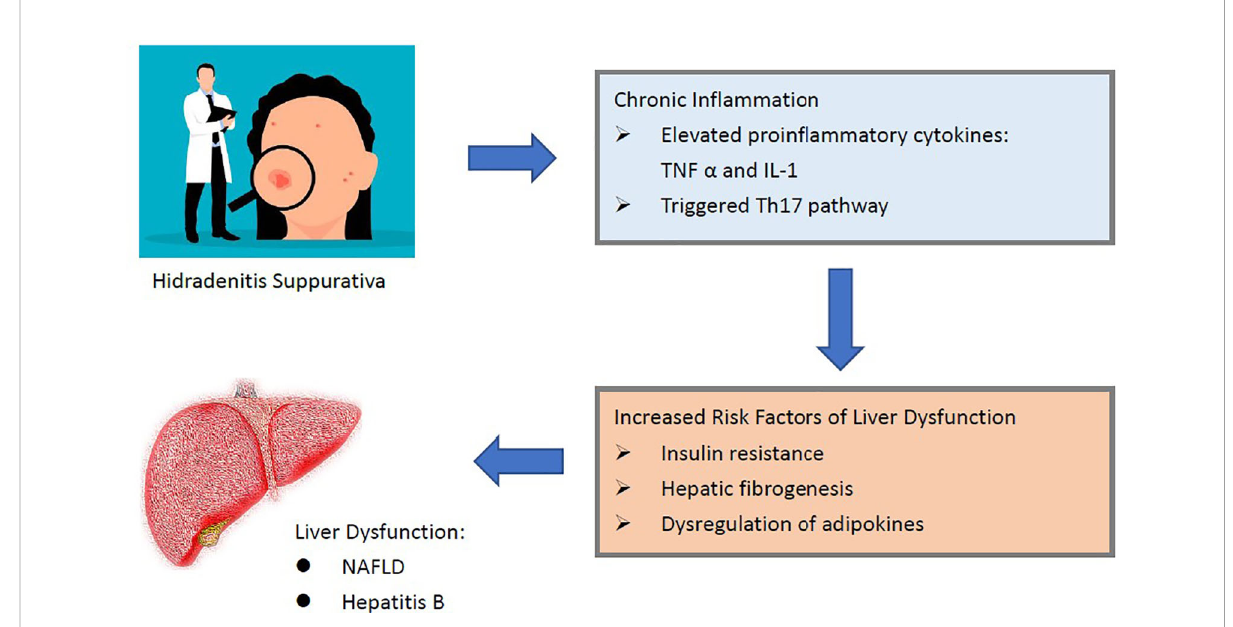
FIGURE 4 Potential mechanisms between HS and liver